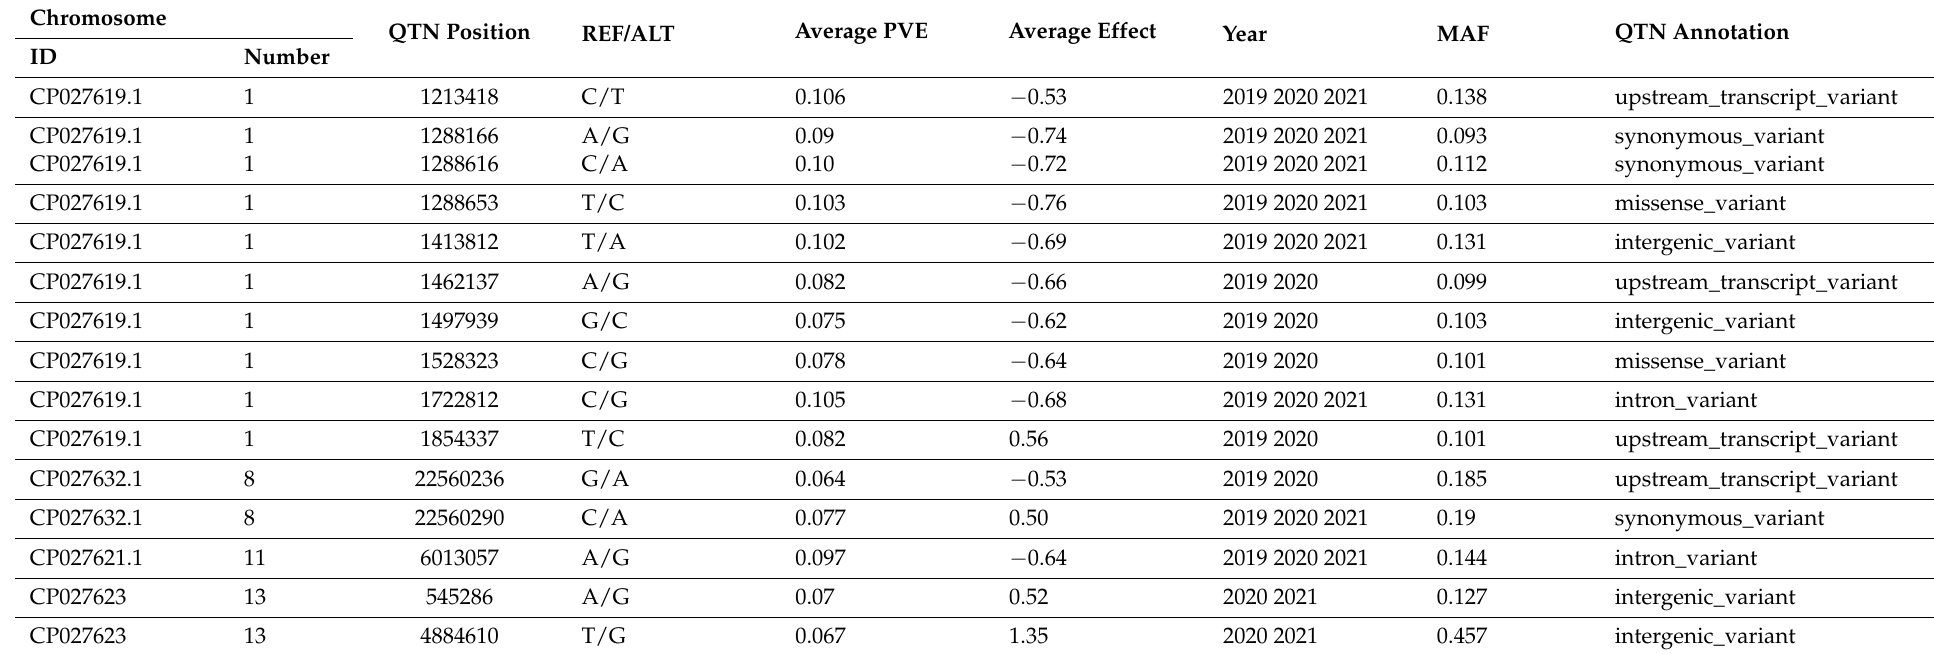
Table 1. List of stable QTNs identified by several models and in at least two